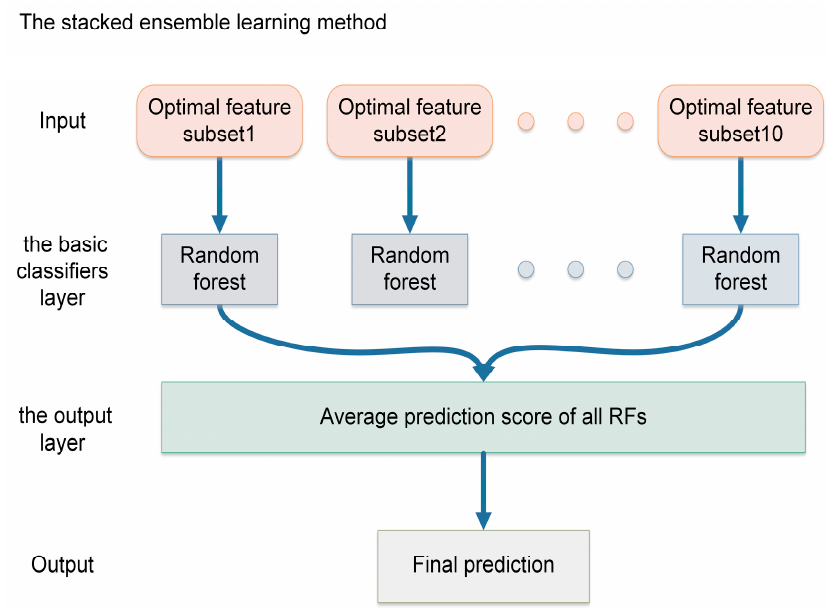
Figure 2. The architecture of the stacked ensemble learning method.